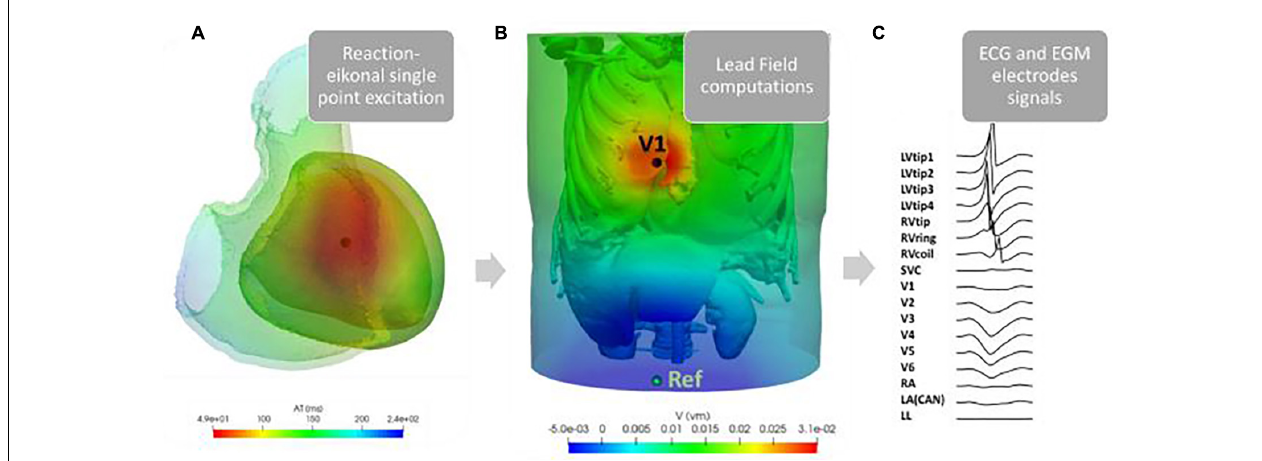
FIGURE 3 | Example of our simulation pipeline. RE single point excitations were simulated in ∼ 3767 different locations across the LV [an example of the activation time map generated for a single such paced beat is shown here in (A) ]. These solutions were combined with the LF matrices computed on the standard nine ECG leads (V1–V6, RA, LA, and LL), and nine EGM sensing points (LVtip1–4, RVtip, RVring, RVcoil, SVC, and CAN = LA), here shown in (B) for LF on V1. The final signals at each lead, shown in (C) , were then combined to obtain vector combinations shown in Figures 4E,F .